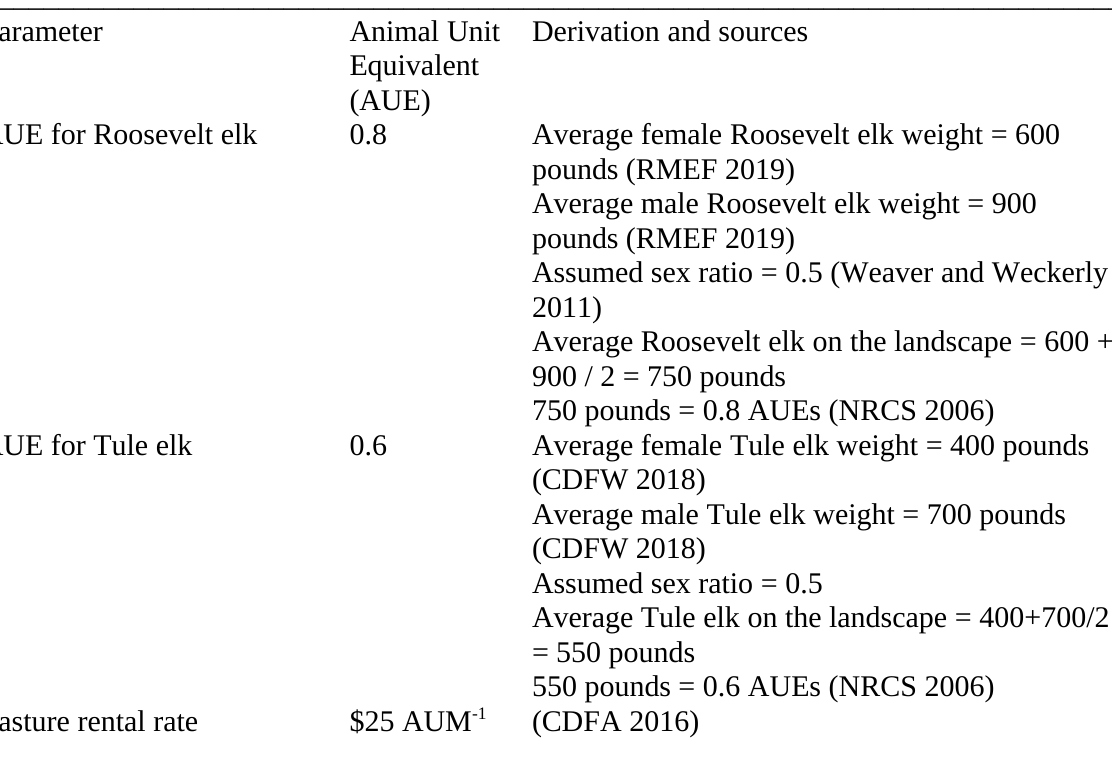
Table A2.1. Fixed parameters for pasture loss calculations. Animal unit equivalents (AUEs) are defined as fractions of what a 1,000 pound beef cow (with calf) consumes (NRCS